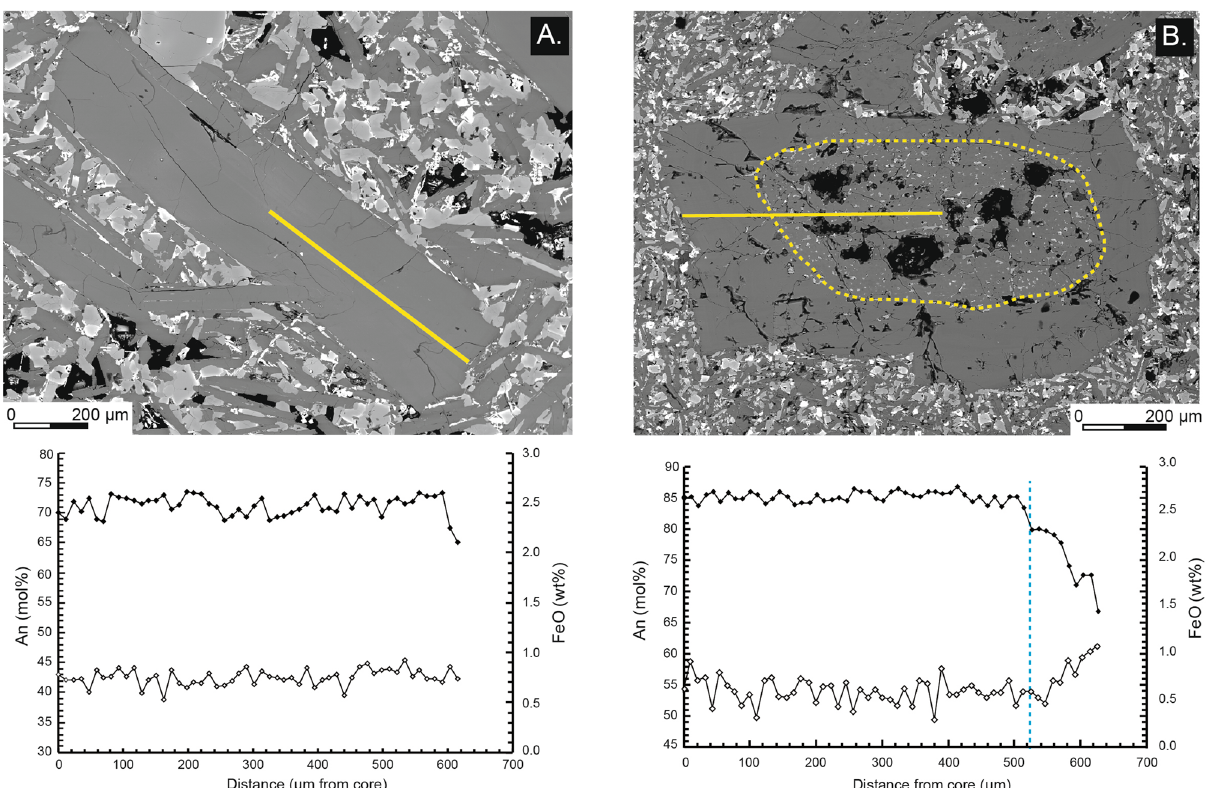
Figure 3. Back-scattered electron images acquired through SEM and compositional core-to-rim profile of selected plagioclase crystals of MSC (no phenocrysts exist in EF). (A) Plagioclase with oscillatory zoning pattern and small amplitude variations of An contents. ( B) Plagioclase with dissolved core texture, with a typical rounded core marked by a ΔAn 5–9 decrease at fairly constant FeO contents.